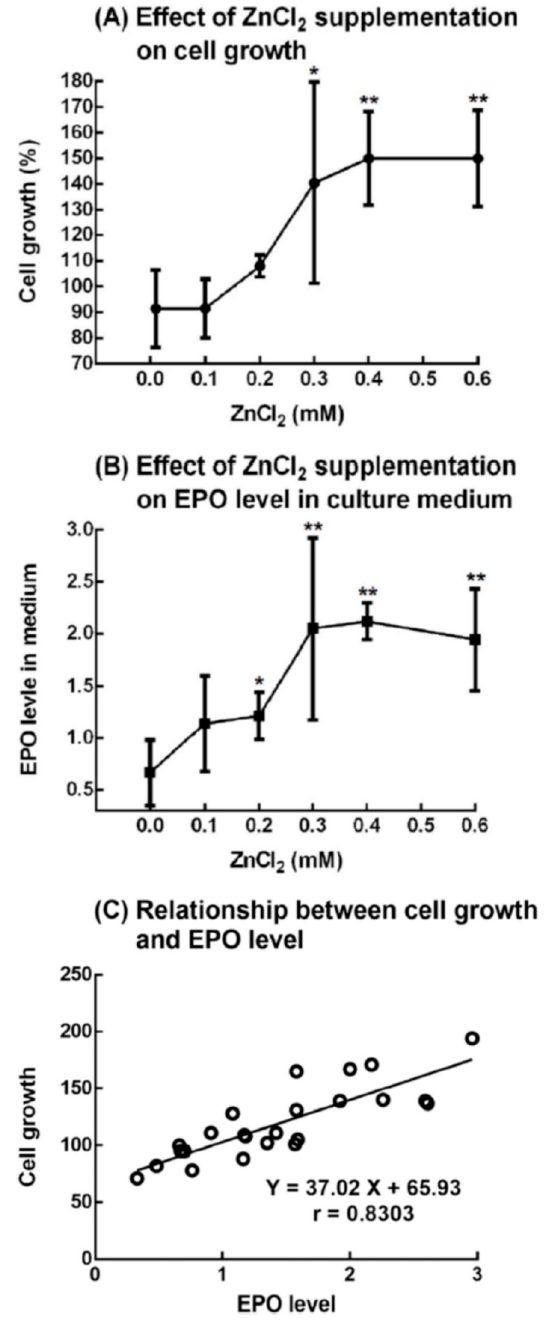
Figure 8. E ff ect of ZnCl 2 supplementation on the growth of 5.1- µ m cells (immature reticulocytes) and production of EPO from rat bone marrow cells. Rat bone marrow cells in the medium and rat serum were suspension-cultured with di ff erent concentrations of ZnCl 2 . The group without the supplementation of ZnCl 2 (zinc concentration in the medium = 0.01 mM) was referred to as the control group, and the ZnCl 2 -supplemented groups (zinc concentrations of 0.1 to 0.6 mM) were referred to as experimental groups. After 1 day, the cultured cells were harvested: ( A ) E ff ect of ZnCl 2 supplementation on cell growth. The cell growth is expressed as the ratio of the number of 5.1- µ m cells at day 1 to that at day 0. ( B ) E ff ect of ZnCl 2 supplementation on EPO levels in the culture medium. The EPO level is expressed as the ratio of EPO concentration at day 1 to that at day 0. ( C ) Relationship between cell growth and EPO level. The results are the mean ± SD from four independent experiments. * p < 0.05; ** p < 0.01: Significant di ff erence between the ZnCl 2 supplemented and control groups ( n =